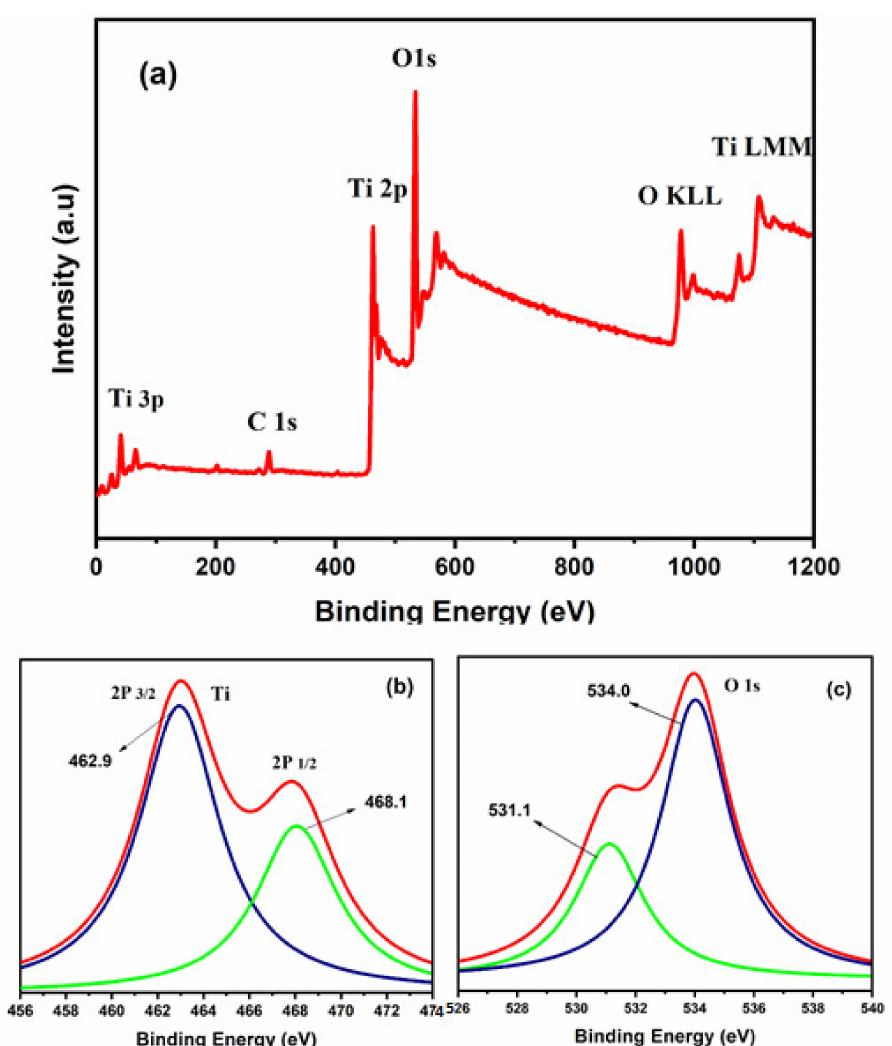
Figure 3. ( a ) XPS survey of the as-synthesized TiO 2 nanoparticles, ( b ) high-resolution Ti 2p, and ( c ) O 1s XPS